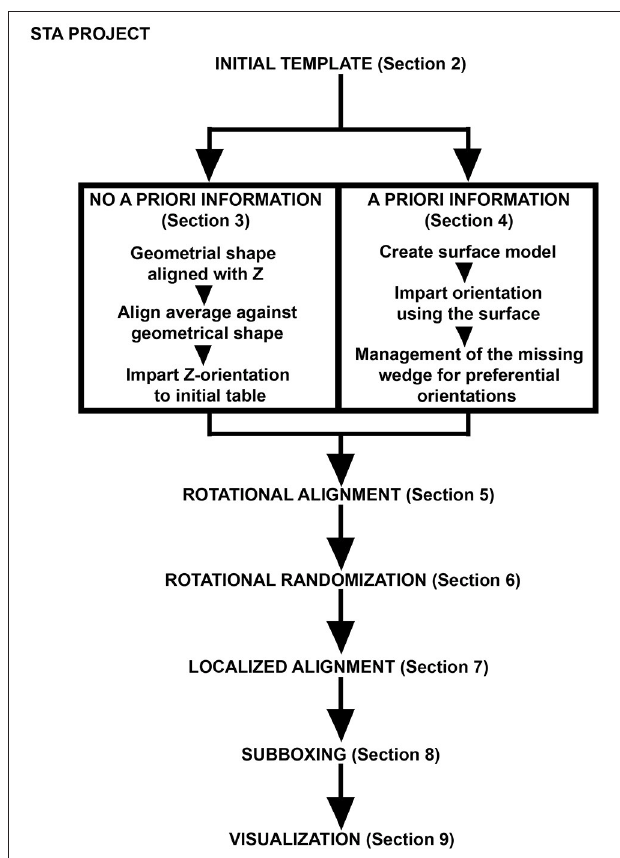
FIGURE 1 | Pipeline for FHV docking site STA. Scheme describing the main steps of the protocol described. The initial template is either oriented by a series of geometrical operations imposed on the particles (no a priori information) or by a surface model representing the OMM where the FHV docking sites are inserted ( a priori information). Management of the missing wedge is an essential step where azimuthal randomization may help, because the particles possess axial symmetry. Different STA projects are designed in order to obtain an optimal density map of the FHV docking site where automatic assignment of asymmetry is managed by subboxing. Eventually, Dynamo visualization tools depict the FHV docking sites as anchored macrocomplexes at the OMM in a 3D